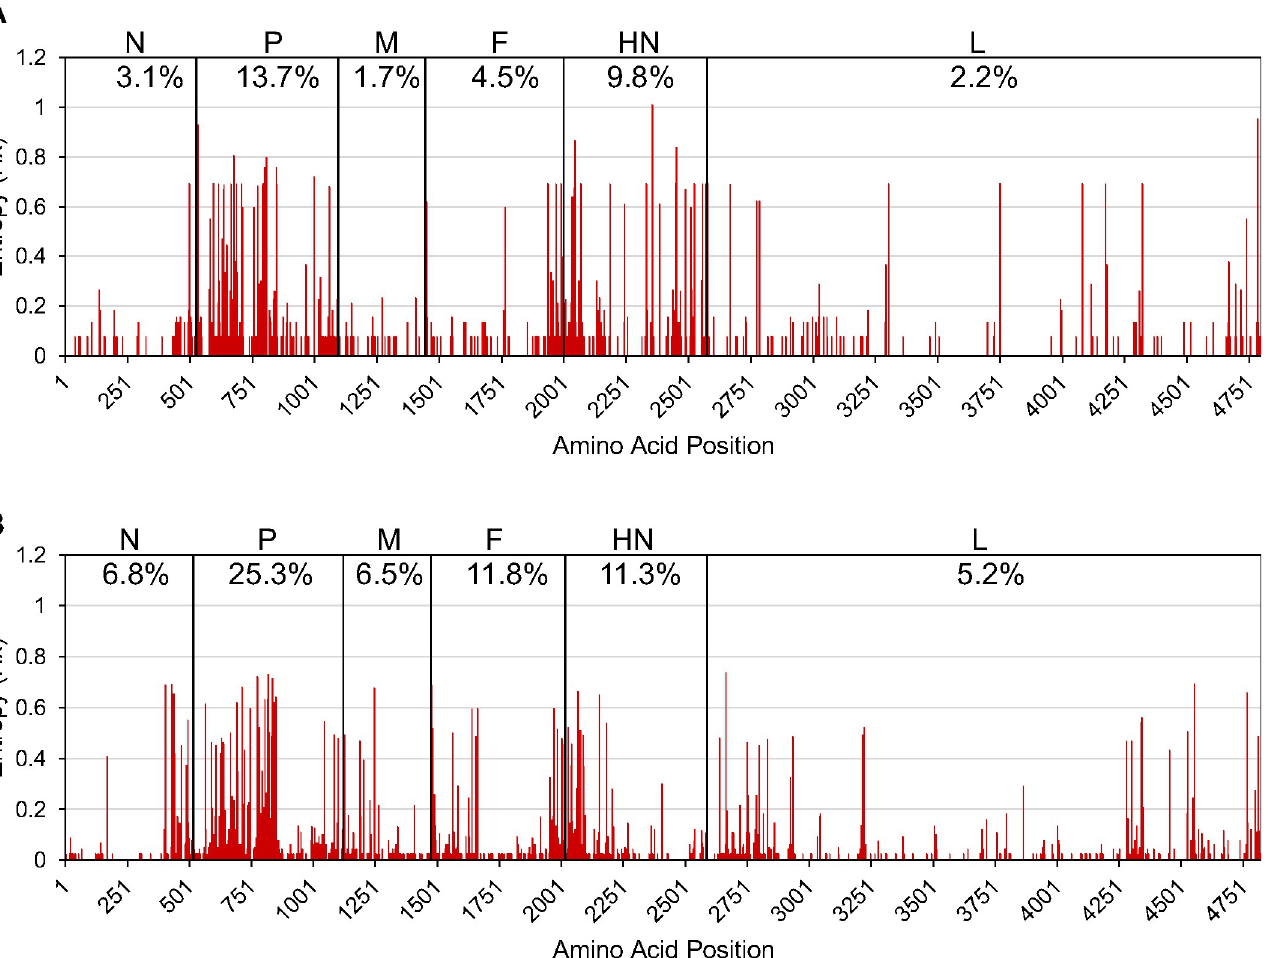
Fig 1. Entropy plots of concatenated HPIV-1 (A) and HPIV-3 (B) protein sequences. For each amino acid position in the protein sequence, higher entropy values represent greater amino acid variation. Abbreviated protein sequence names are shown across the top of the plot in the order in which coding sequences are arranged in the genome. The percentage values show the percentage of positions in the protein that have a mutation present in more than one sequence.